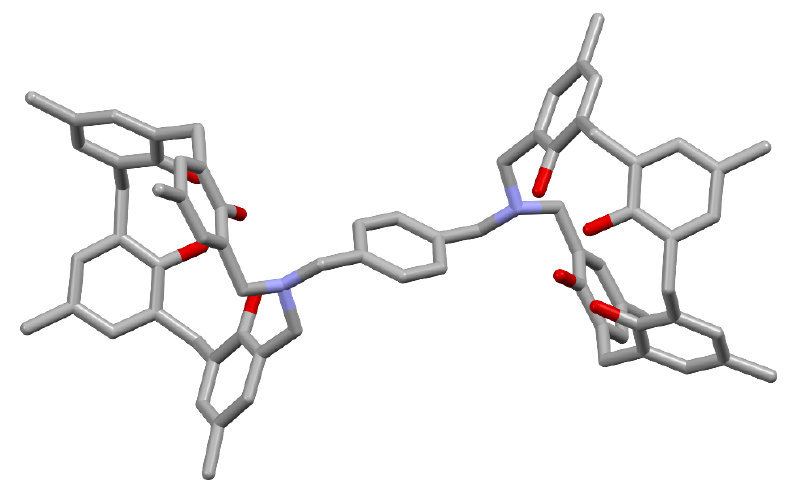
Figure 4. Molecular structure of 22 . Solvent molecules were omitted for clarity.